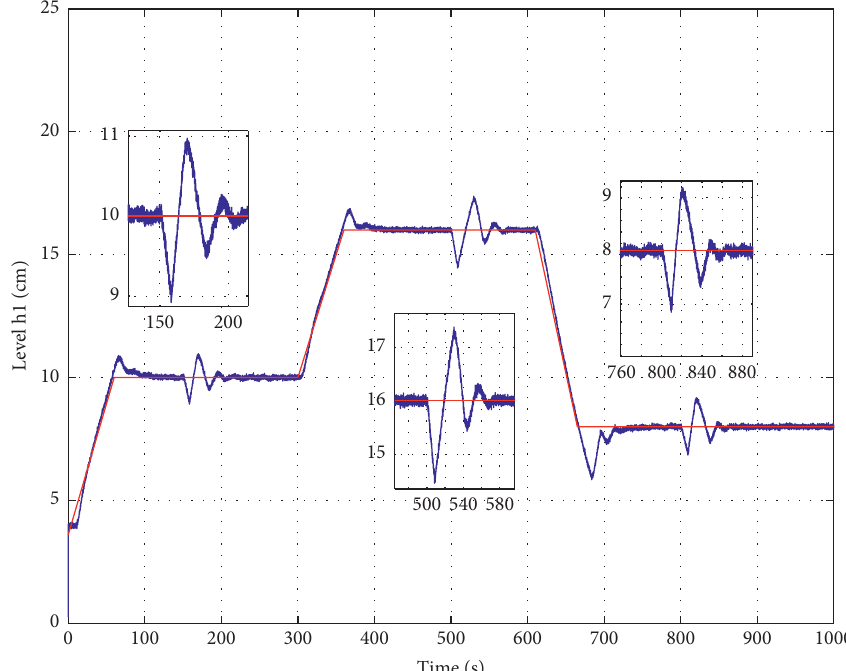
Figure 12: Experimental result for IBC tracking and its impact on parameter